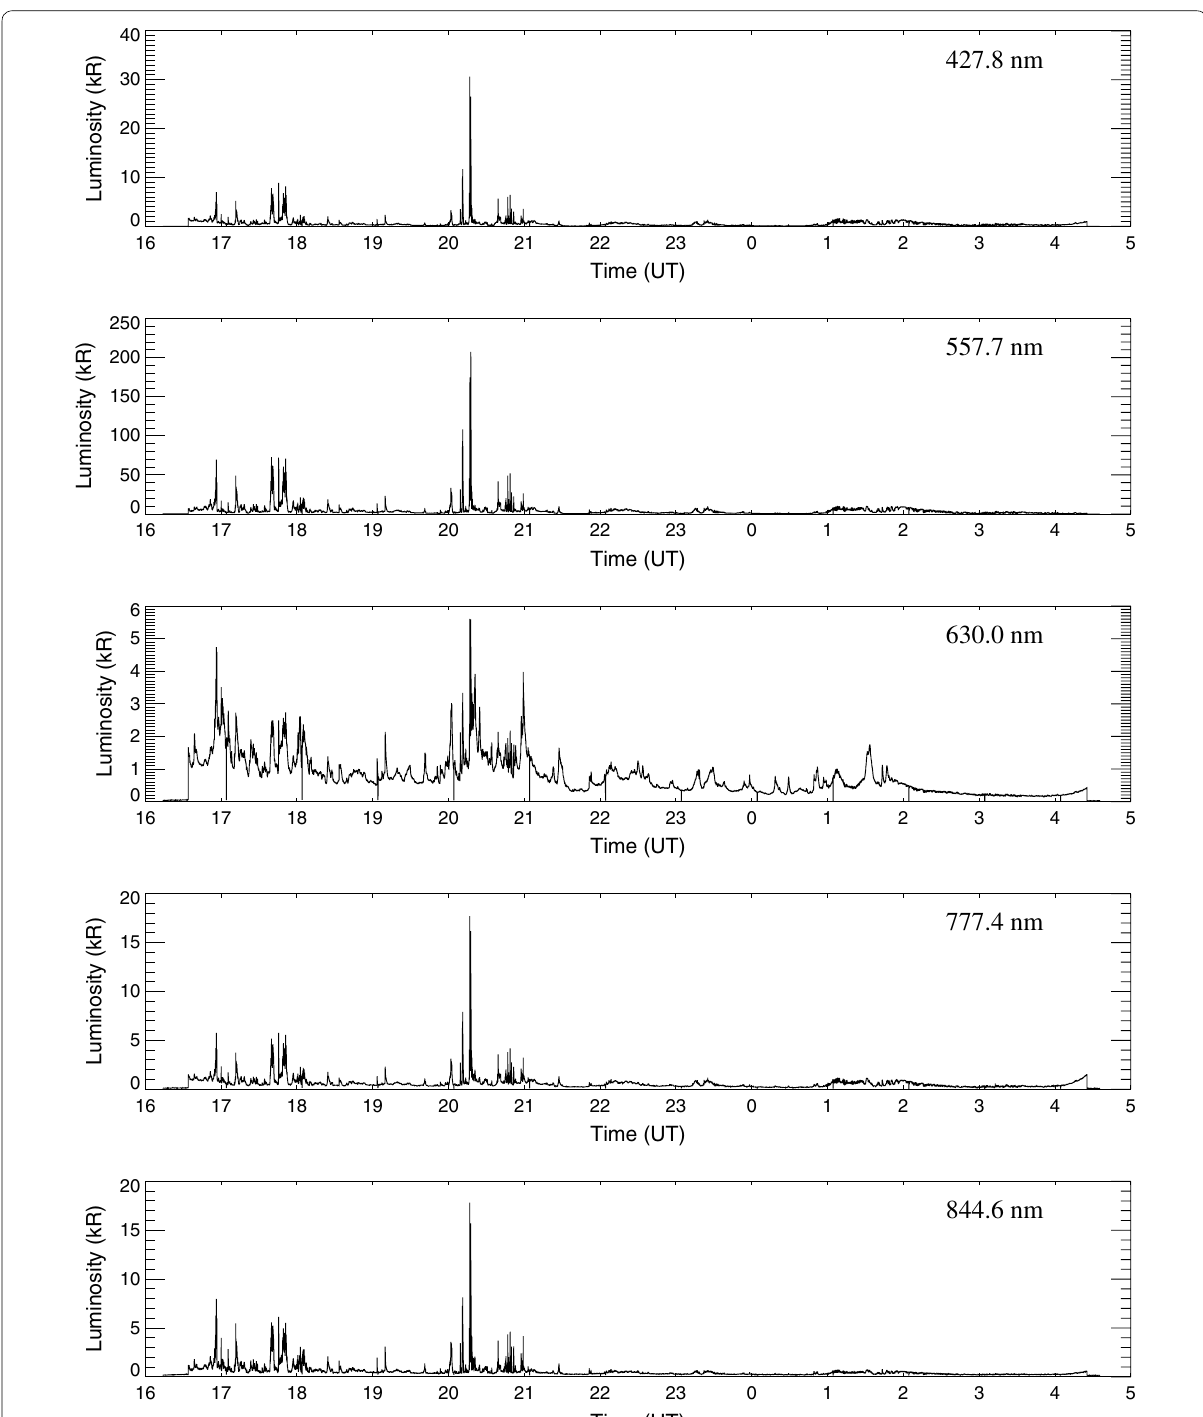
Fig. 5 Temporal variations of the auroral emissions obtained with the photometer with five wavelengths between about 16:34 UT on October 19 and about 04:25 UT on October 20, 2017. The emissions of 427.8 nm, 557.7 nm, 630 nm, 777.4 nm, and 844.6 nm (1 s of averaged data) are presented from top to